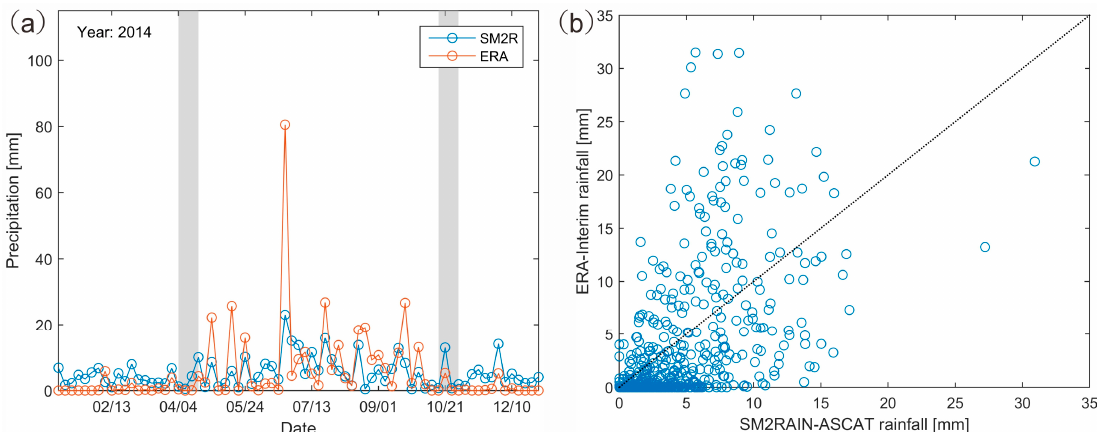
Figure 8. The difference between SM2RAIN-ASCAT and ERA simulation in typical Weishan irrigation district in the center of the Huang-Huai-Hai (HHH) Plain. ( a ) the 5-day accumulation time series in 2014; ( b ) the scatter plot of SM2RAIN-ASCAT vs. ERA-Interim rainfall during 2007–2015.